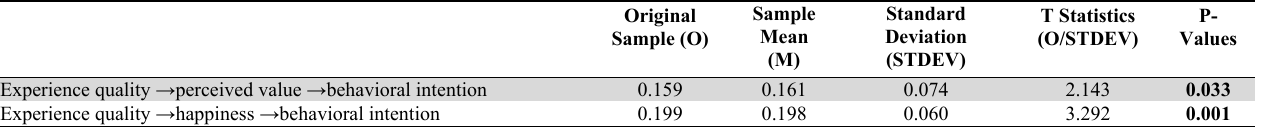
The results of testing the indirect effect hypothesis